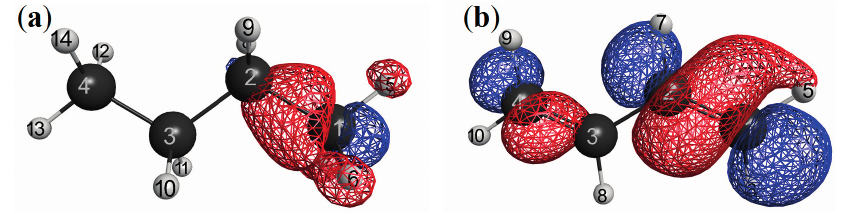
Figure 12. Isosurfaces of linear response functions for the perturbations on the right terminal C